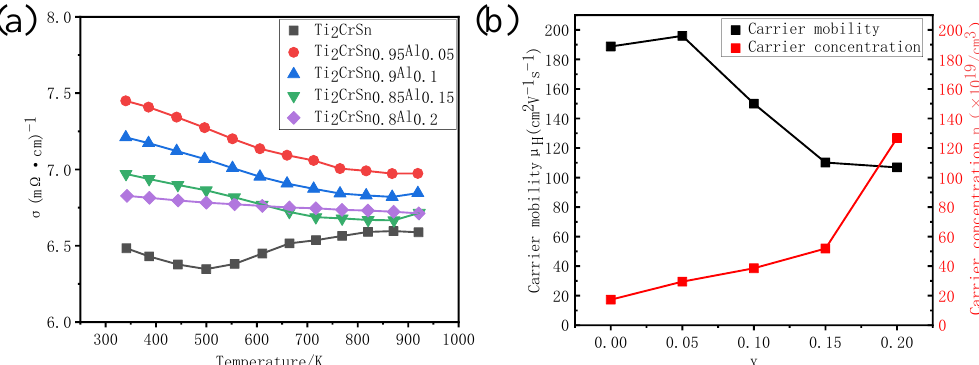
Figure 4. ( a ) Temperature dependence of conductivity for the Ti 2 CrSn 1 − x Al x (x = 0, 0.05, 0.1, 0.15, 0.2) alloy; and ( b ) variation in carrier mobility and carrier concentration with respect to Al doping at 296 K.